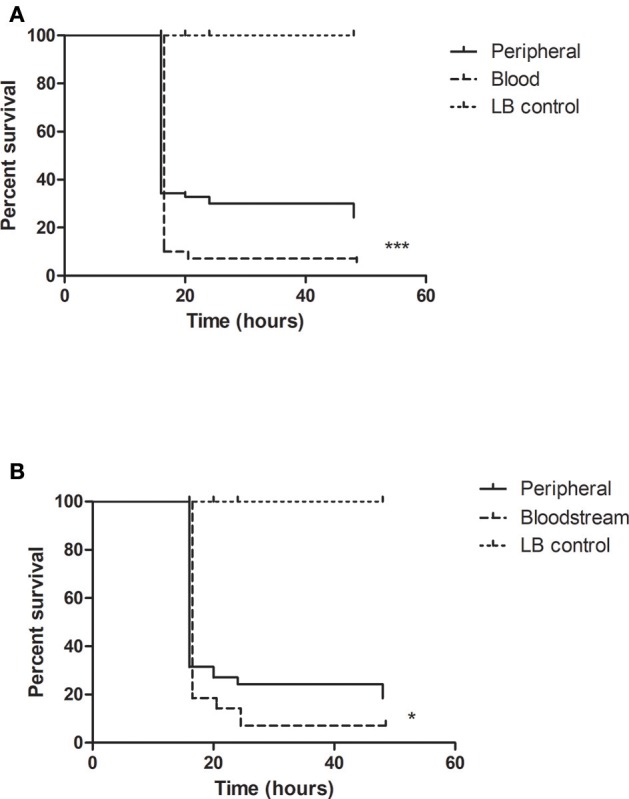
Bloodstream isolates of P. aeruginosa are more virulent than peripheral isolates. Survival analysis comparing (A) 37 peripheral and 12 bloodstream P. aeruginosa isolates, and (B) 7 pairs of peripheral and bloodstream P. aeruginosa was grown statically in LB broth for 48 h followed by generation of CFS (cell-free supernatant) by centrifugation and sterile filtration of the liquid culture. Twenty microliters of the CFS was injected into the larvae for this experiment. Survival was assessed over a 48-h time period ***p < 0.0001, *p = 0.025 log-rank log-rank (Mantel-Cox) test (Graphpad Prism).